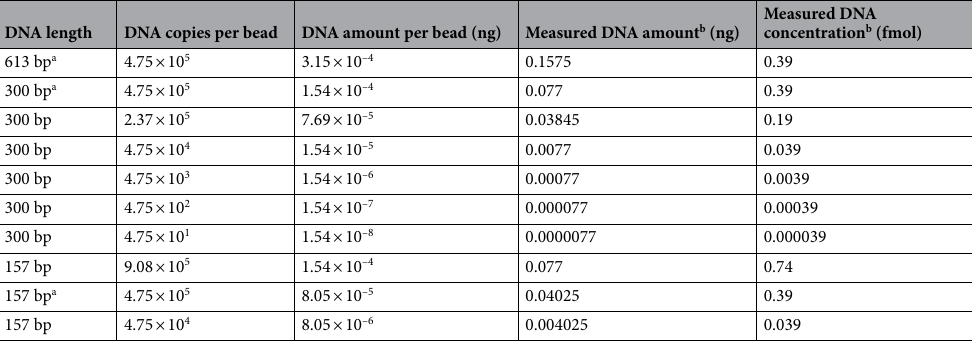
ance amplifier (Fig. 1d). Different quantities and sizes of DNA immobilized onto paramagnetic beads not only modulate the overall diameter of the DNA beads as compared to bare beads, but also influence surface potential, conductance, and permittivity. Each of these physical parameters was associated with differences in impedance measurements at different frequencies. Figure 1e shows the representative multi-frequency (7.5 MHz, 10 MHz and 15 MHz) time series data of bare paramagnetic beads in a 2.5 s time window. Traces are normalized with respect to the baseline impedance for ease of comparison. Each double peak observed corresponds to a single bead passing over the two electrodes. The reason for the double peak is due to the fact that when a bead flows directly above one electrode, a relative larger perturbation to the electric field is created compared to the bead flowing through the space between the two electrodes, thus resulting in two smaller peaks superimposed on a large peak. The bead can be modeled as a capacitor and a resistor in series with each other, which is parallel to the resistance of the solution. As frequency increases greater than 5 MHz, the impedance decreases due to the parasitic capacitance, which creates a path for the electric field parallel to the conductive solution, thus making the beads more permeable to the electric field generated by the electrodes. The impedance difference between beads containing DNA compared to bare beads without DNA was significantly larger at higher frequencies (> 500 kHz), due to the dominance of surface potential, conductance, and permittivity in impedance, as opposed to lower frequencies where impedance peak response (IPR) was primarily dictated by bead diameter. The sum- ming of peak intensities of each bead across the frequency spectrum enabled maximum differentiation between different bead populations. To determine the physical mechanism that allows for bead differentiation in the frequency region of interest, we performed measurements on beads of the same size but with differing surface potentials (See SI Appendix, Fig. S1). Beads with larger surface potential displayed a higher average distribution of IPR, suggesting that one of the mechanisms for DNA detection was a change in surface potential. Previous work 40 involving DC current measurements relied on changes in diameter. We have tested 3 different types of magnetic beads (M270, M280 and C1). Based on the properties and the nature of our sensor we chose to proceed with M280. DNA detection by impedance cytometry.